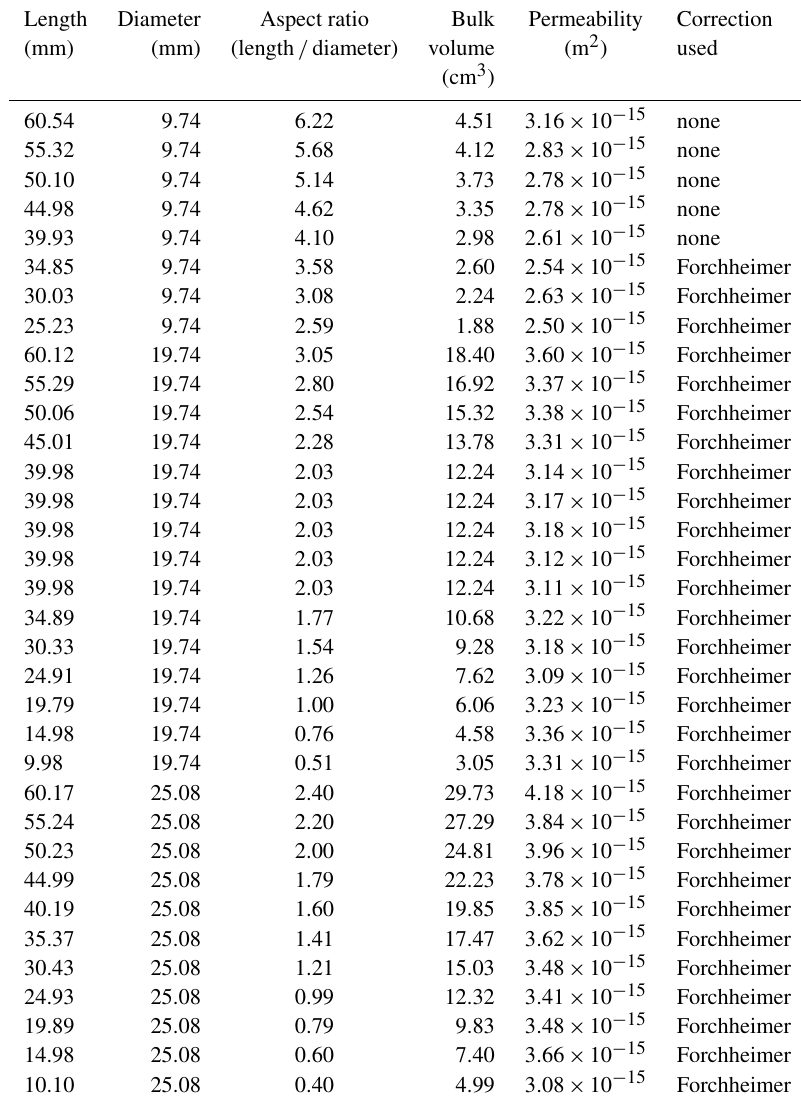
Table 1. Summary of the experimental data collected for this